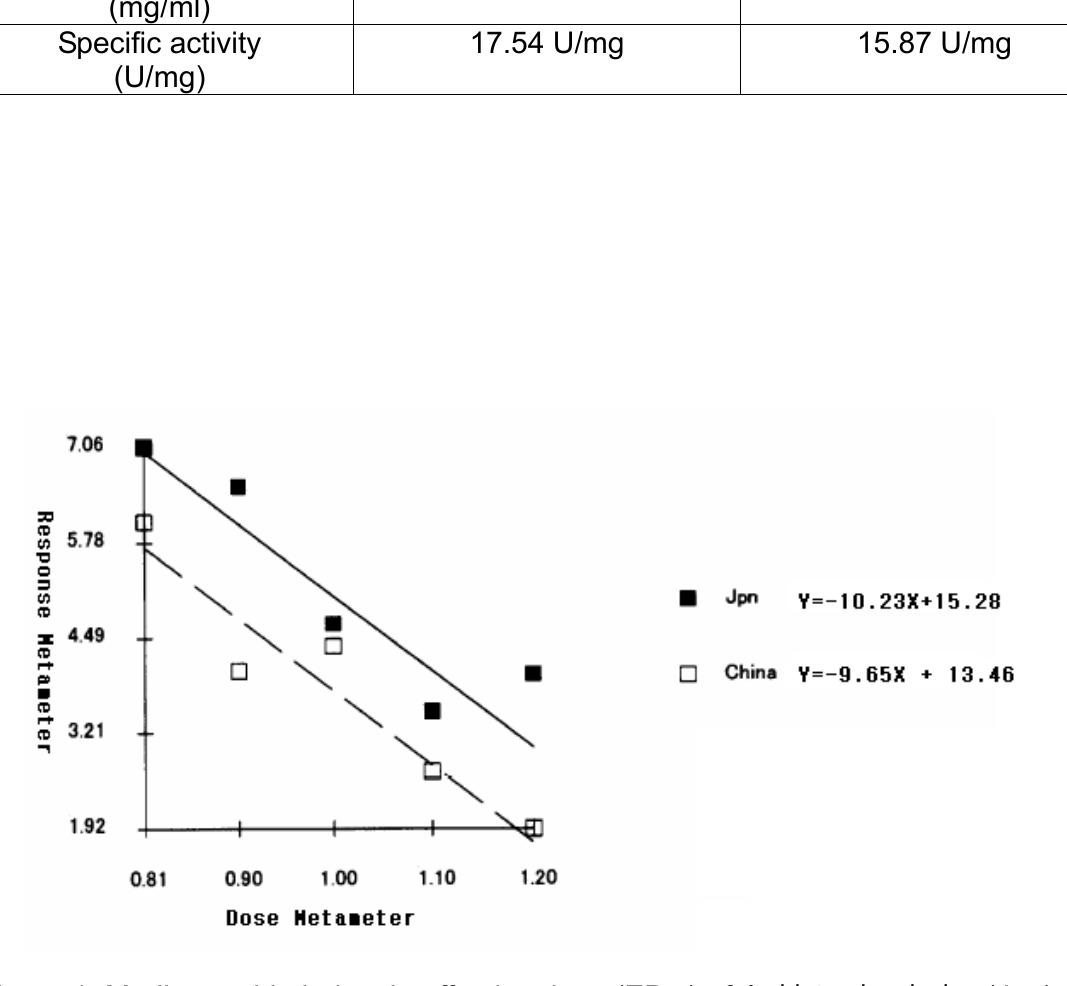
) of Agkistrodon halys (Jpn) and 50